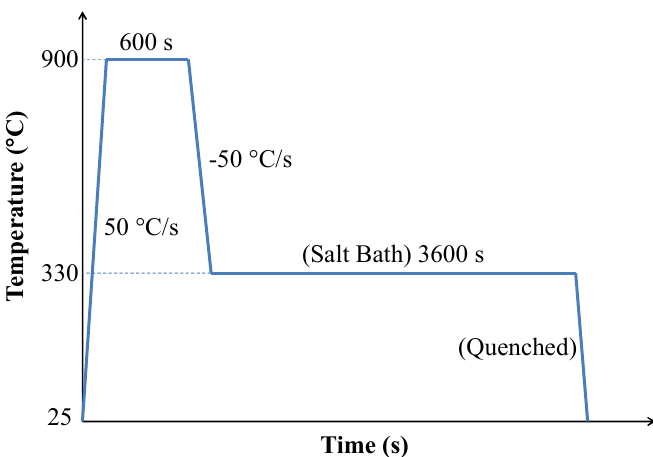
Figure 3. Scheme of the planned heat-treatment process.